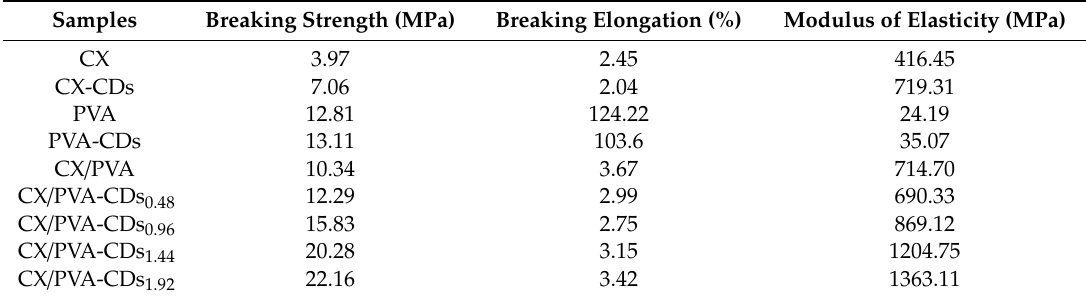
Figure 5. ( a ) Stress-strain curves of CX, CX-CDs, PVA, and PVA-CDs; ( b ) stress-strain curves of CX/PVA and CX/PVA-CDs. Table 1. The breaking strength, elongation, and modulus of CX, PVA, CX/PVA, CX-CDs, PVA-CDs, and CX/PVA-CDs films.